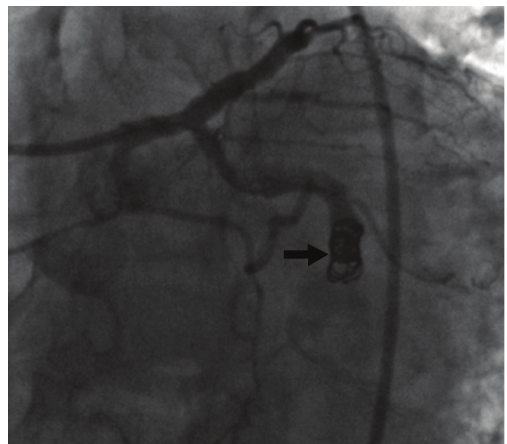
Figure 3: Successful coiling with no blood flow into the aneurysm